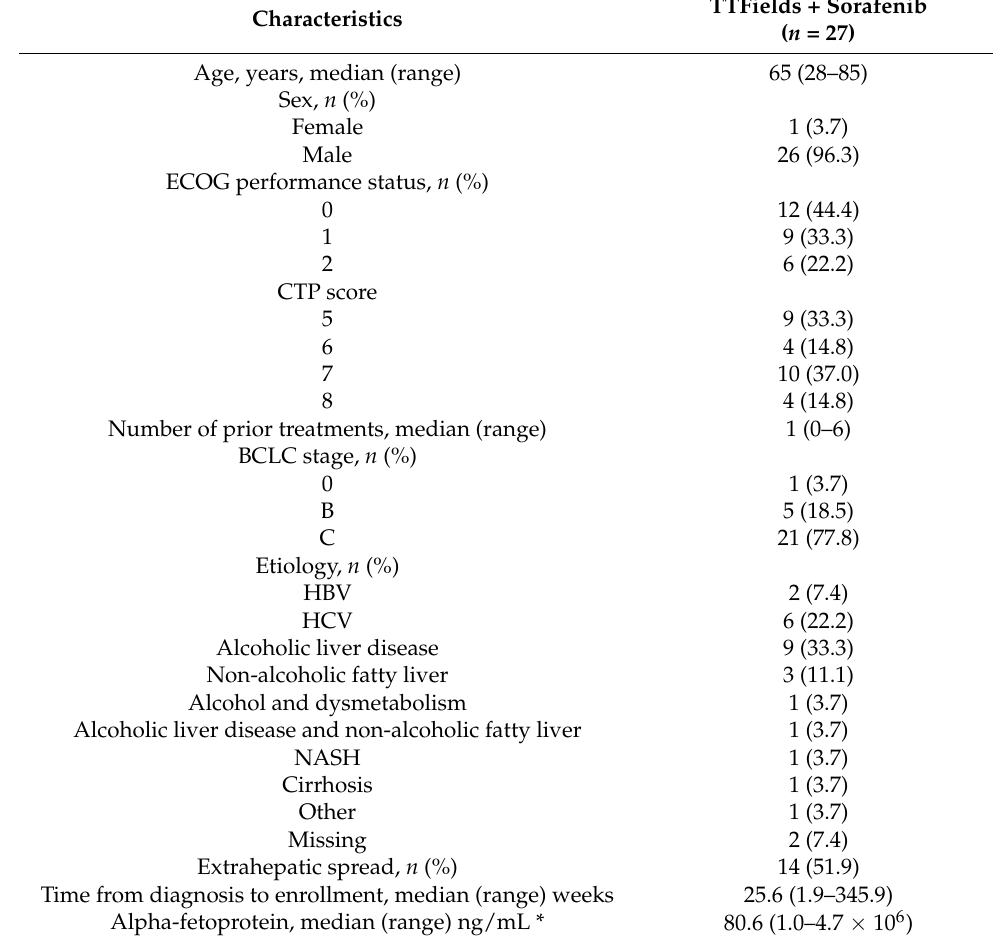
Table 1. Patient baseline and disease characteristics treated with TTFields concomitant with sorafenib. Characteristics